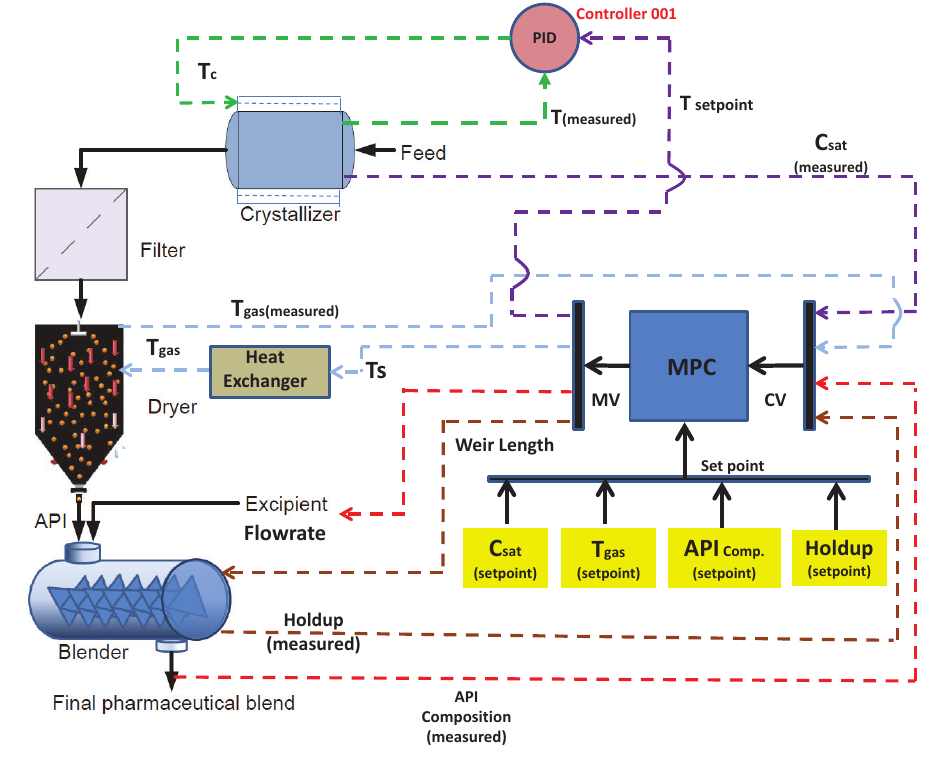
Figure 2. Pictorial representation of the closed-loop continuous process. PID (proportional-integral-derivative); MPC (model predictive control); MV (manipulated variable/actuator); CV (control